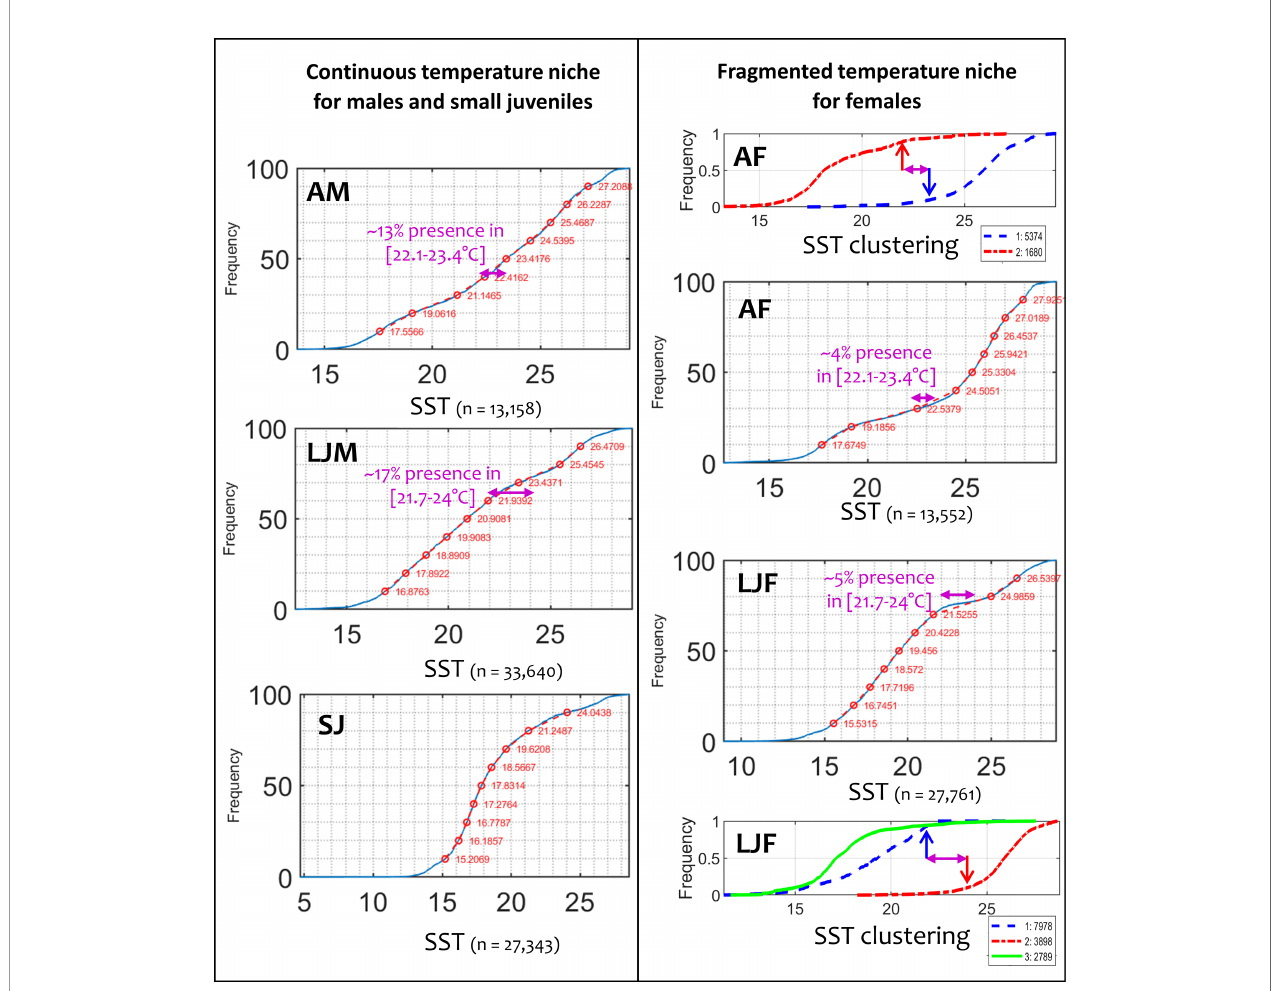
FIGURE 4 | Global distribution of sea surface temperature ( SST ) by size and sex class of blue shark. A continuous SST niche for males and small juveniles (left panels) and a fragmented SST niche for large juvenile and adult females (right panels) is evident, with three to four-fold lower presence of females than males in the SST range of 21.7-24°C and 22.1-23.4°C,